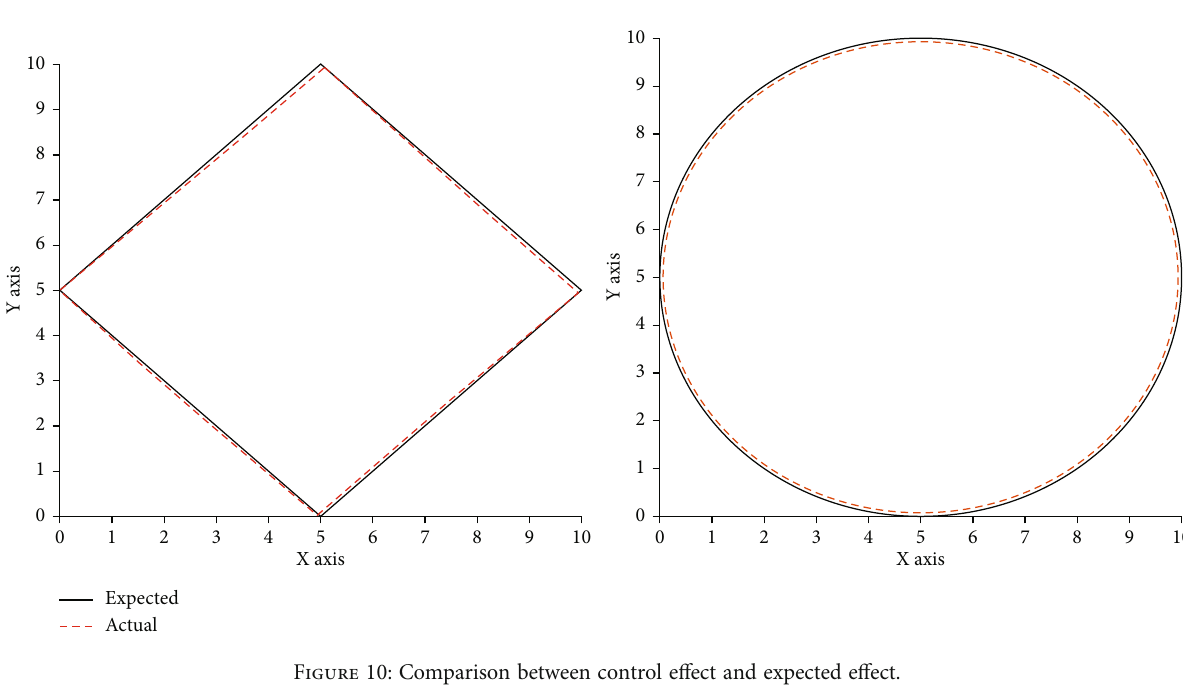
Figure 10: Comparison between control e ff ect and expected e ff